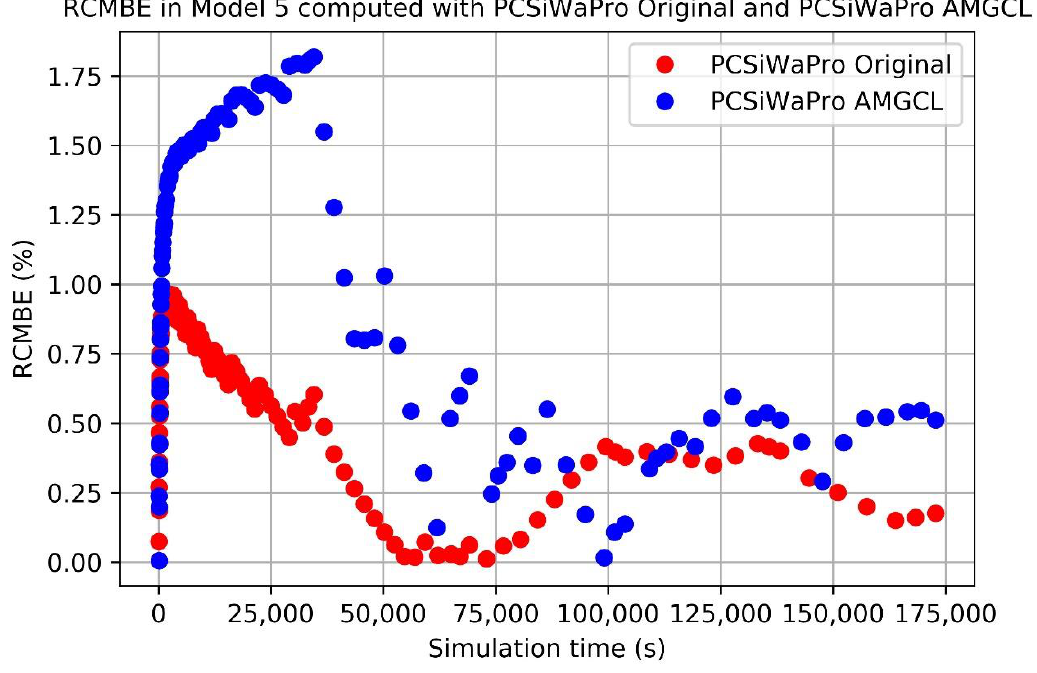
Figure 5. The RCMBE in Model 5 computed with PCSiWaPro Original (red) and PCSiWaPro AMGCL (blue). The results computed with PCSiWaPro Original do not violate the aim of a RCMBE of at most 1%. However, the results computed with PCSiWaPro AMGCL violate this rule in the first quarter of the simulation period.